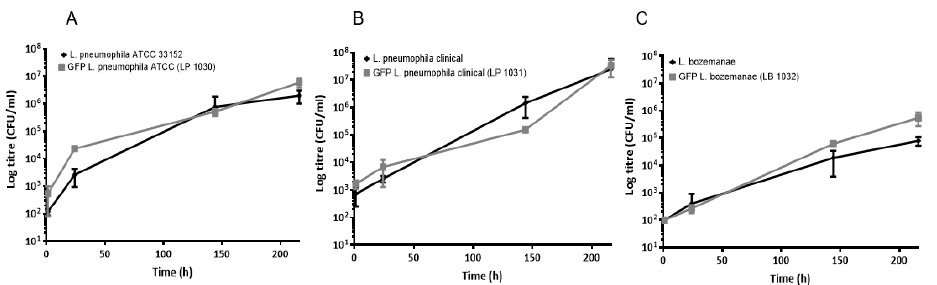
Figure 3. In vivo growth curves for the GFP-tagged Legionella and wild-type strains. Parental strains and GFP-tagged L. pneumophila ATCC 33152 ( A ), L. pneumophila clinical isolate ( B ) and L. bozemanae ( C )strainswere grown in Acanthamoeba castellanii at 25 °C. Infections were performed at an MOI of 0.1 and Legionella intracellular growth was determined at 1, 48, 144, and 216 h post-infection. The parental strains are displayed in black, while the GFP strains are shown in gray. All experiments were performed in triplicate, and data represent the mean ± standard errors. ATCC, American Type Culture Collection; CFU, colony-forming units; GFP, green fluorescent protein; MOI, multiplicity of infection.